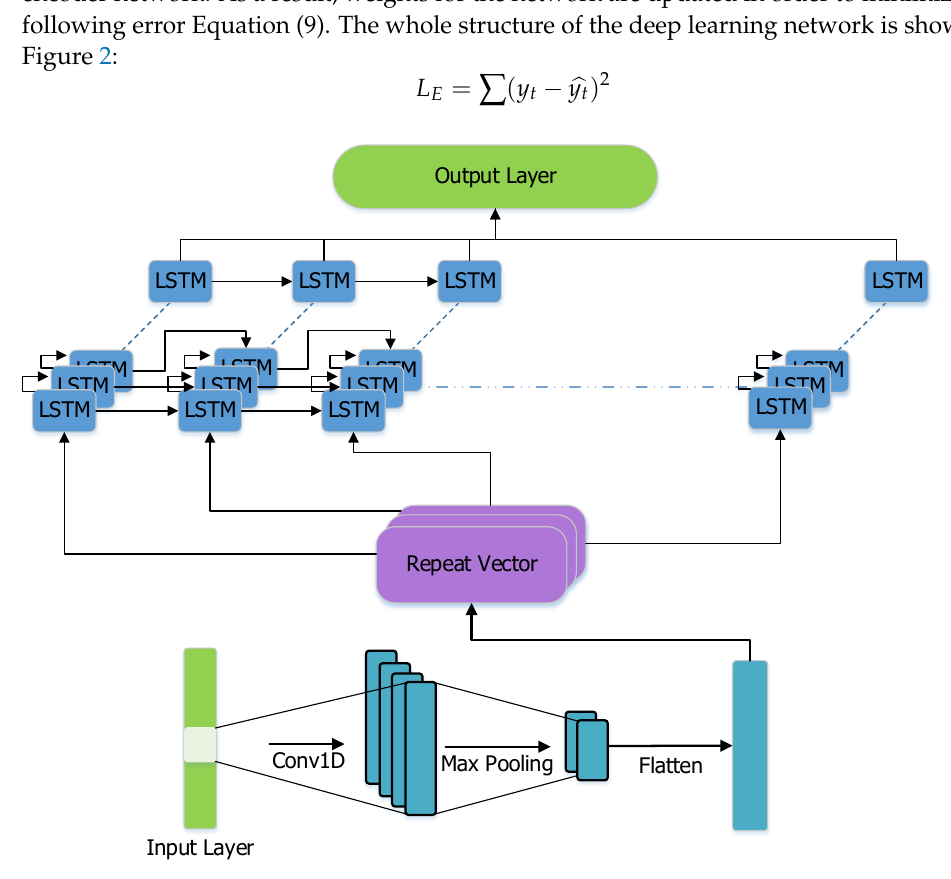
Figure 2. CNN-LSTM auto-encoder sequence to sequence